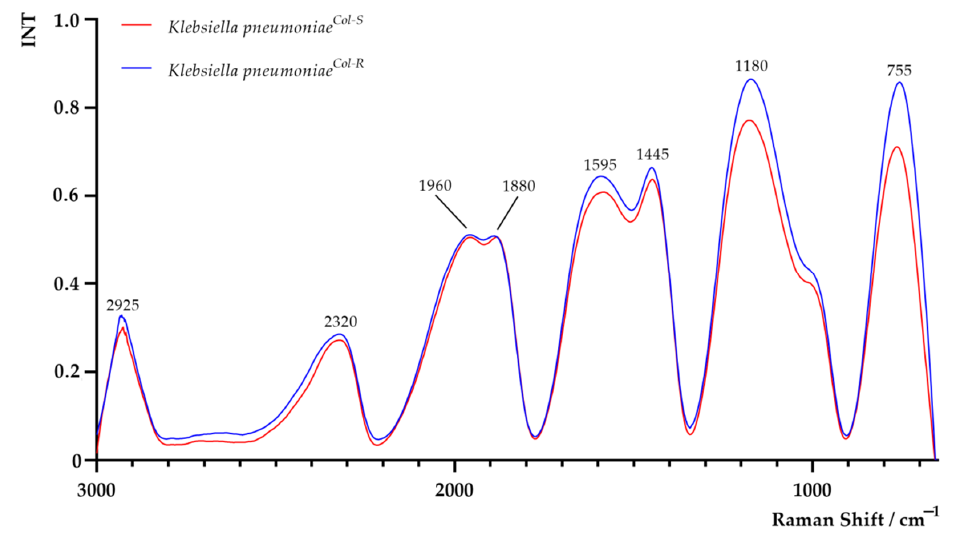
Figure 4. Raman spectra of colistin-susceptible ( K. pneumoniae Col-S ) and laboratory-induced high-level colistin-resistant Klebsiella pneumoniae ( K. pneumoniae Col-R ) strains.